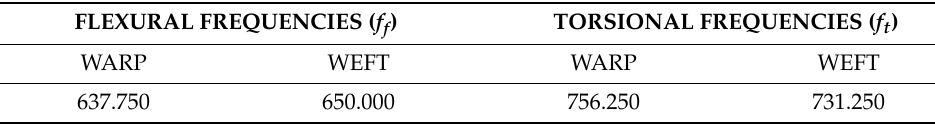
Table 4. Flexural ( f f ) and torsional frequencies ( f t ).